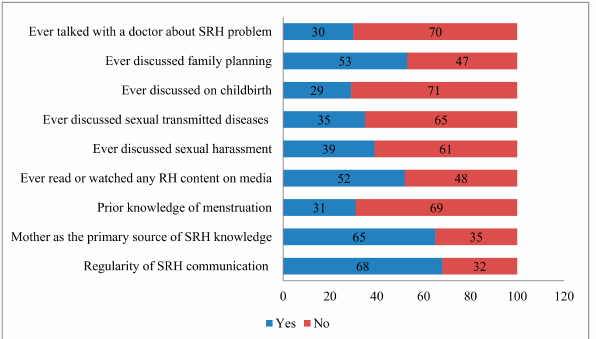
Figure 1. Percentage distribution of older adolescent girls’ sexual and reproductive health (SRH)-related